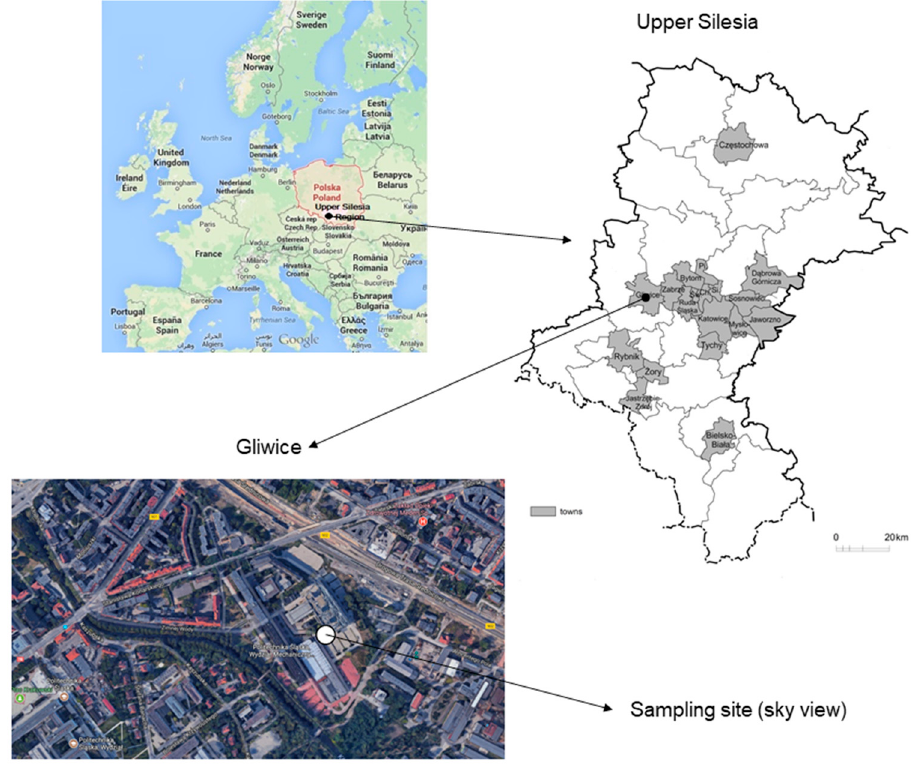
Figure 1. Location of bioaerosol measurement campaign (map data: 2017© Google, ORION-ME).